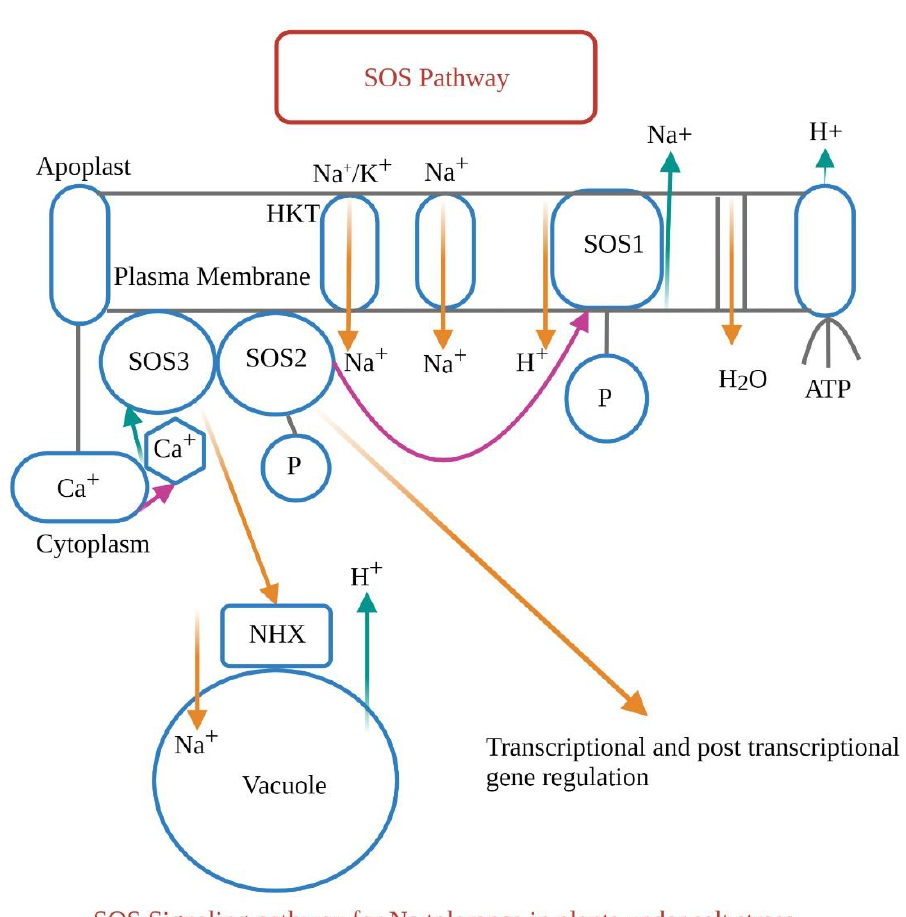
Figure 4. SOS signaling pathway functions in ion homeostasis and Na + extrusion from cytosol; A rise in cytosolic calcium is induced by high extracellular salt concentrations. The calcium sensor SOS3 interacts with and activates the protein kinase SOS2 when it detects a signal. The ion transporter activities of transcription factors (TFs) are then regulated by activated SOS2 to regulate ion homeostasis or gene expression. The SOS1 Na + /H + antiporter, the NHX vacuolar Na + /H + exchangers, and the Na + /H + transporter HKT1 are all SOS2 targets. Tonoplast ATPase and pyrophosphates, water channels, and the K + transporter are among the other targets.